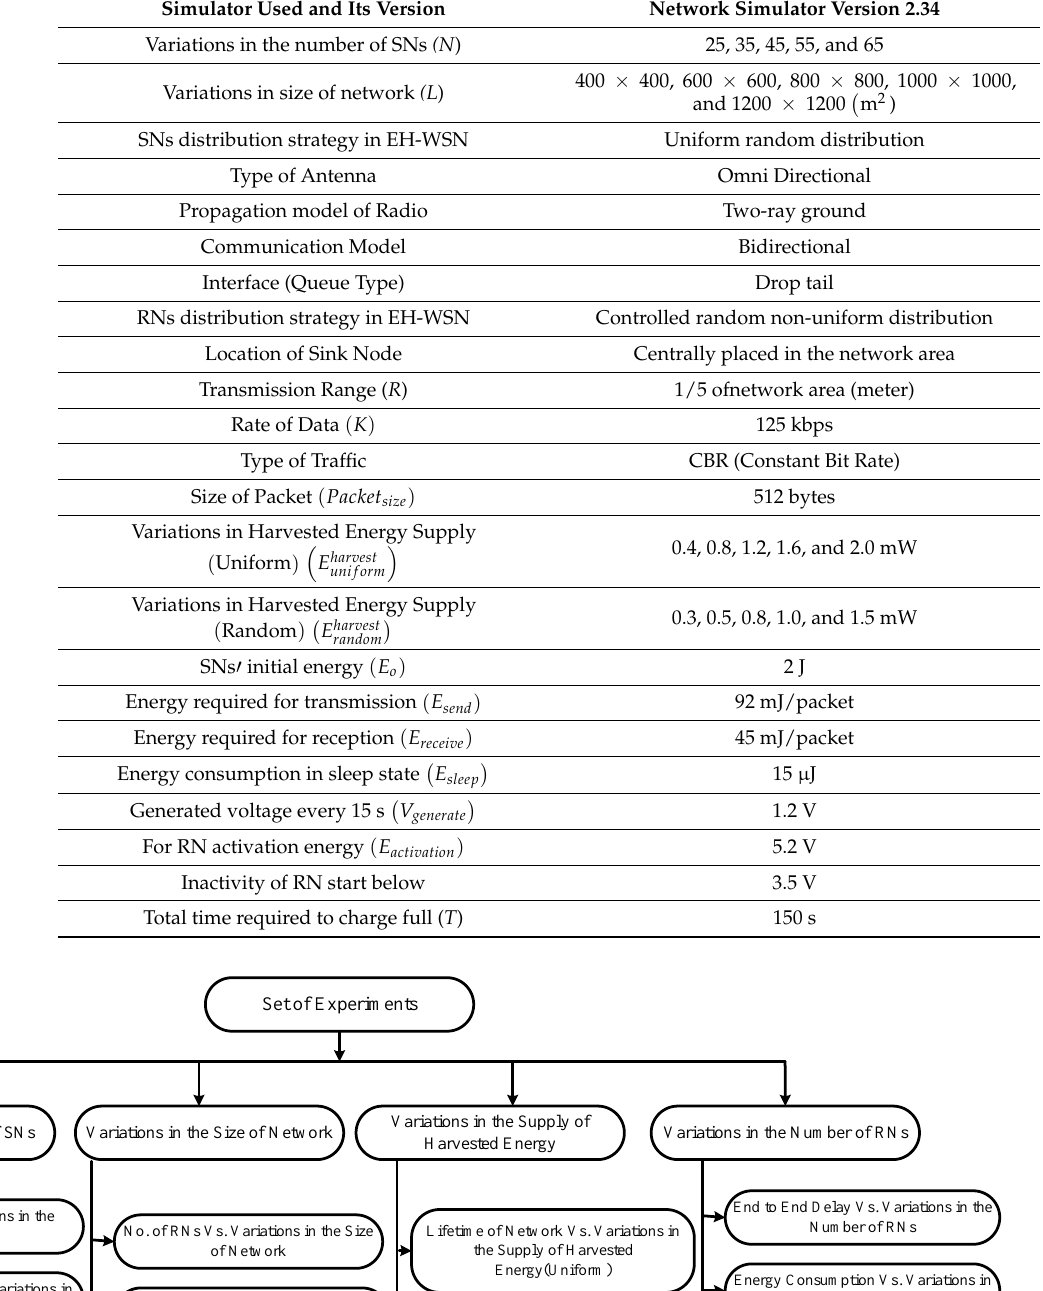
Table 2. The parameters along with their respective values used in the simulation.